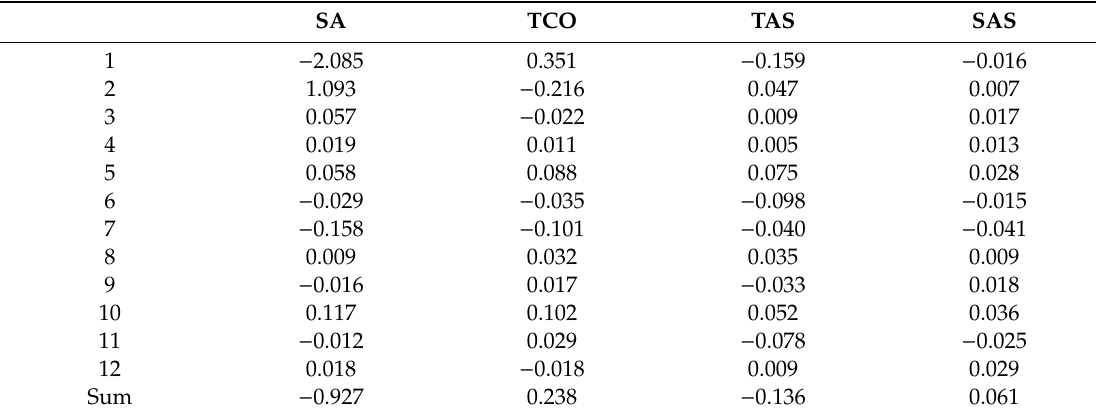
Table 4. Third-order aberration analysis based on the modified thermal control